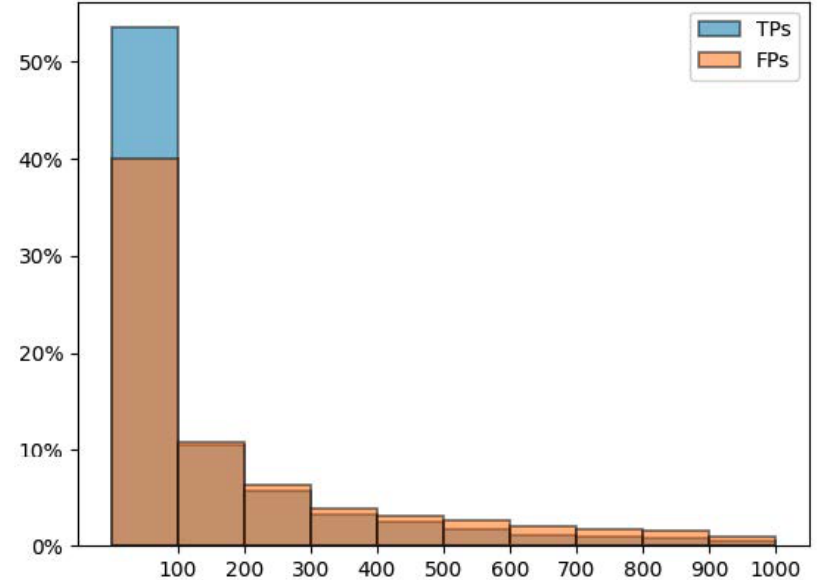
Figure 2. Percentage distribution of TP/FP users that posted within 1–1000 messages after the suicidal